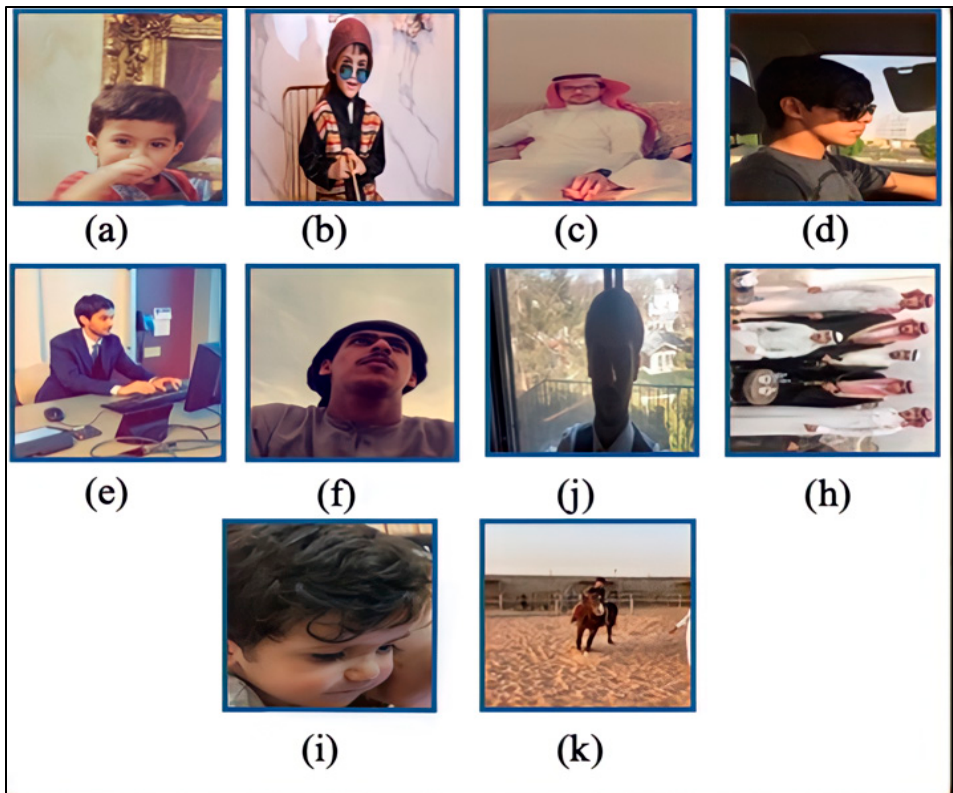
Figure 21. Samples of face not recognized: ( a ) represents the Photograph is old, ( b ) represents wears an accessory, ( c ) represents using a filter, ( d – f ) represents face capture angle to the right or left or down, ( j ) represents dark photos, ( h ) represents the image is flipped left or right, ( i ) represents photo accuracy and ( k ) represents the person is so far